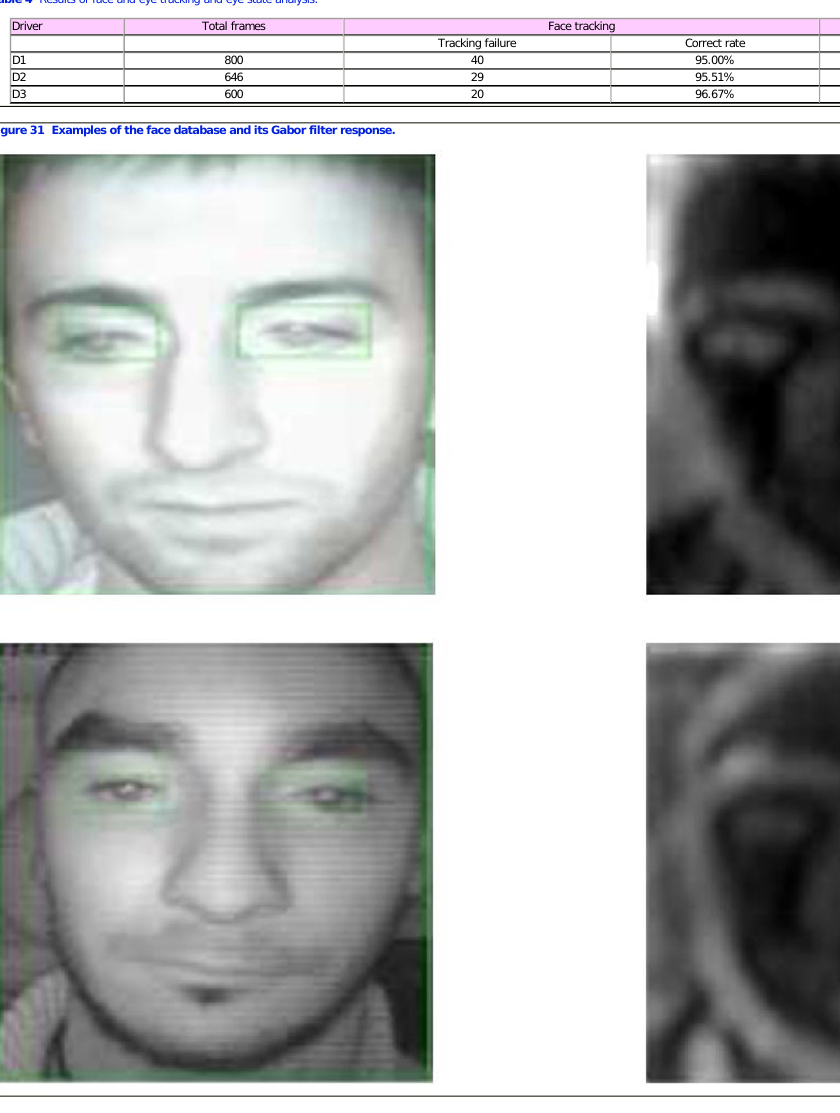
Table 4 Results of face and eye tracking and eye state analysis.